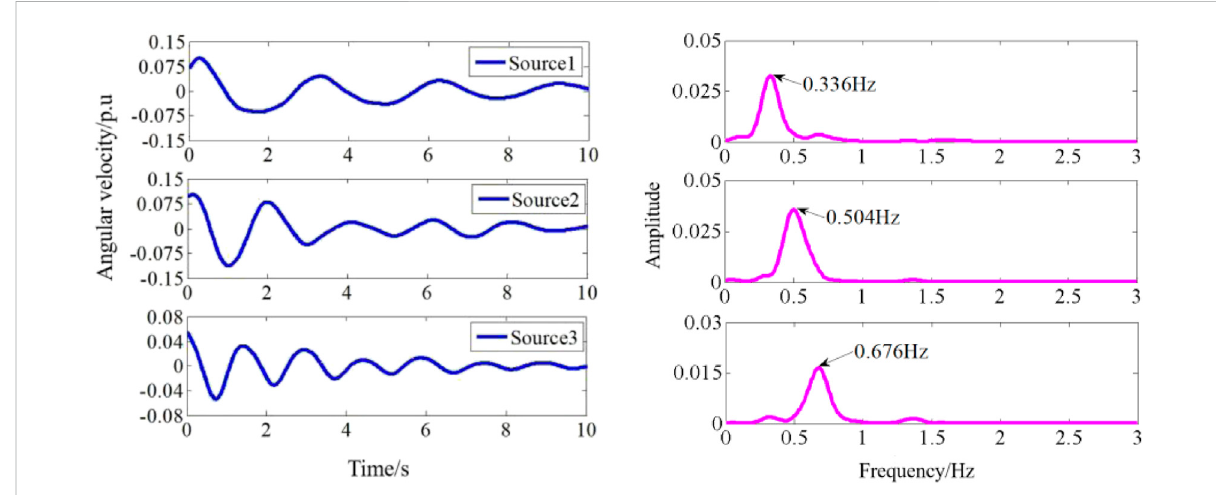
FIGURE 9 The separated single-mode components and their WFT